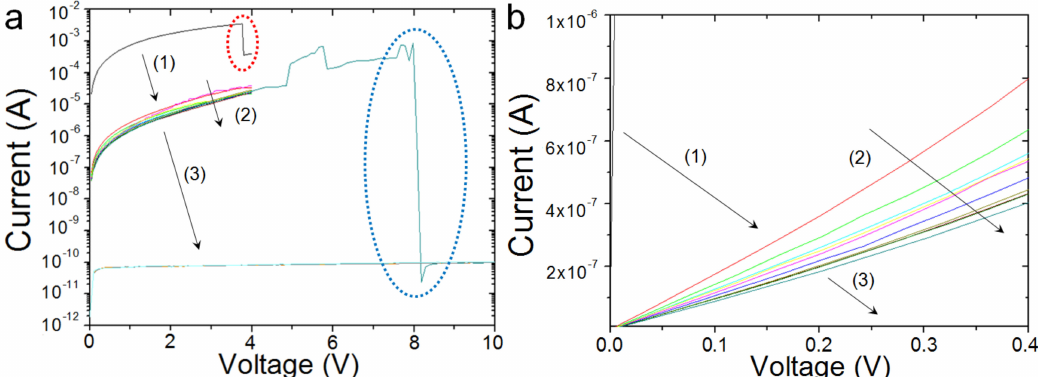
Figure 3. ( a ) Sequences of I-V curves collected at the same position on the surface of a 100 nm Pt/300 nm SiO 2 /Si sample, using a conductive atomic force microscopy (CAFM) connected to an external Keithley 6430 source meter (the Pt film was connected to the CAFM plate using silver paint). The red dashed circle indicates the initial partial degradation of the CAFM tip, followed by an intermediate state (2); the blue dashed circle shows the complete degradation of the CAFM tip. ( b ) The same data is shown in different